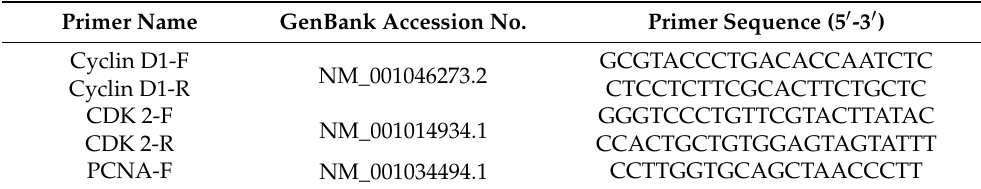
Table 1. Primer sequence of quantitative polymerase chain reaction used in this